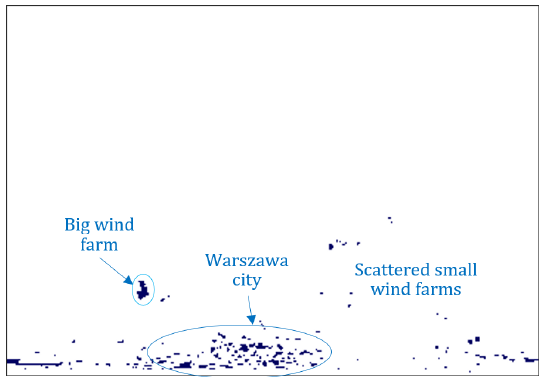
Figure 8. Example of a mask of non-meteorological permanent echoes. Legionowo radar, the lowest